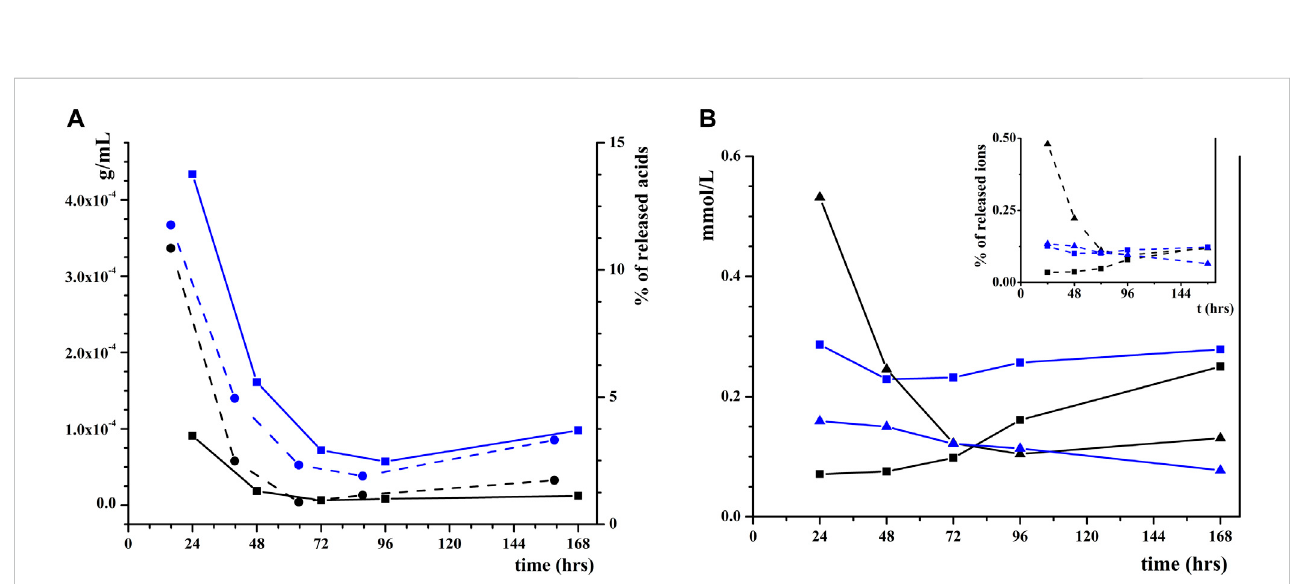
FIGURE 5 (A) ConcentrationsofHAs(black squares) andFAs (blue squares) releasedinpure water and wt%ofthereleased HAs(black circles) andFAs (blue circles); (B) Concentrations and wt% (in the inset) of solubilized P (triangles) and Ca (squares) from HP NPs coated with HAs (black) or FAs (blue).